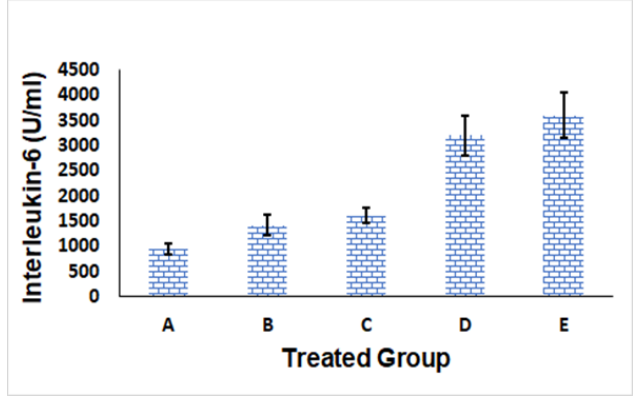
Figure 6. IL-6 levels for different formulations: optimum Gr-PV-NE ( A ), Gr-NE ( B ), PV-NE ( C ), PV-Gr mixture ( D ), and normal saline ( E ).